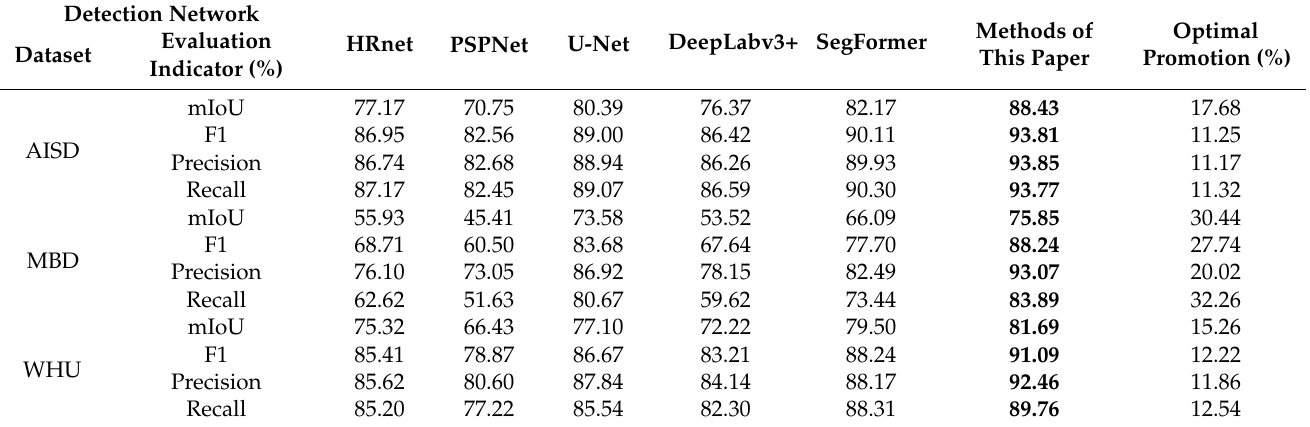
Table 6. Precision comparison of different